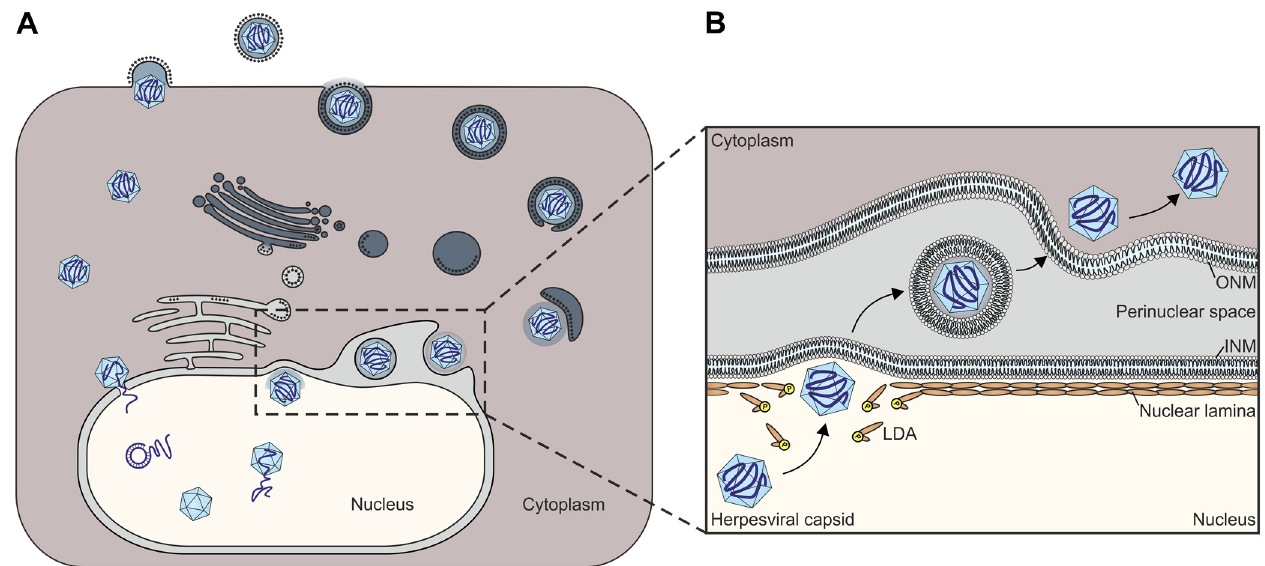
Figure 1. Prototypic replication and nuclear egress of herpesviruses. ( A ) During herpesviral replication capsids are transported to the inner nuclear membrane (INM), where the viral genome is released into the nucleus. In the nucleus, the viral gene replication and expression starts, and the newly synthesized genomes are packed into preformed capsids. The capsids are exported from the nucleus via the nuclear egress ( B ), and in the cytoplasm the virions finally mature and release the cell. ( B ) For the nucleocytoplasmic transport of the capsids, referred to as nuclear egress, the nuclear lamina has to be dissolved by phosphorylation (P) of lamins. At these lamina-depleted areas (LDAs), capsids bud at the INM into the perinuclear space. These primary enveloped virions then fuse with the outer nuclear membrane (ONM), releasing the capsid into the cytoplasm.